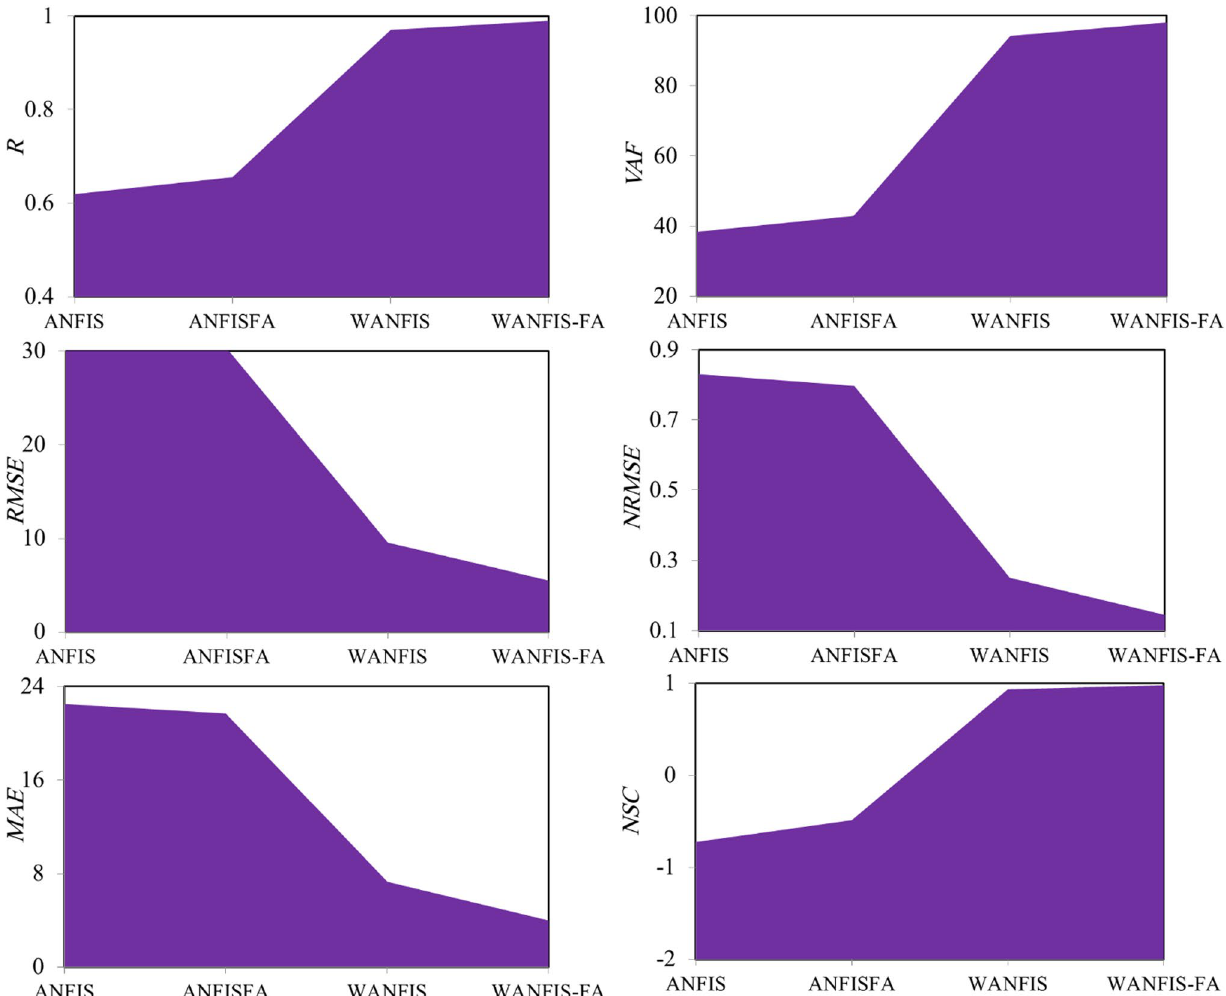
Fig. 13 Comparison of statistical indices calculated for ANFIS, ANFIS-FA, WANFIS and WANFIS-FA